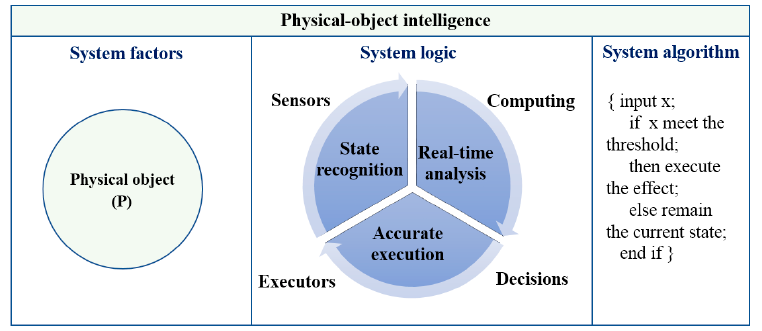
Figure 3. Physical object intelligence (Type I).